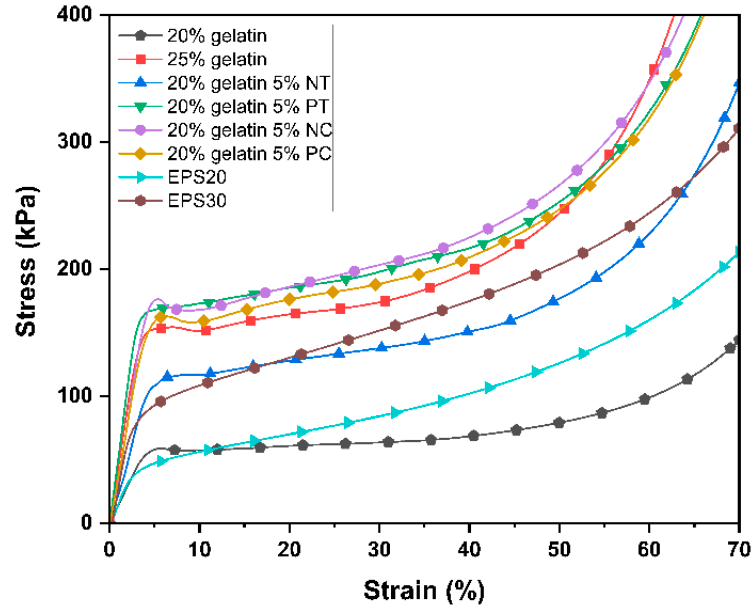
Figure 6. Comparison of typical compressive stress–strain curves (23 °C, 50% RH) for the gelatin and gelatin–starch foams produced by mechanical foaming.